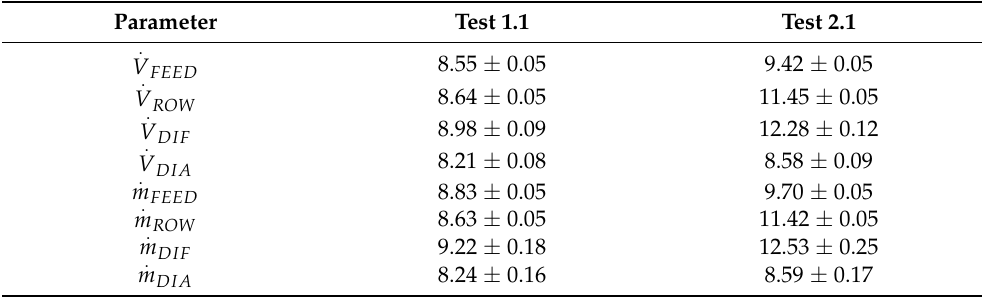
Table 2. Flows of inlet and outlet streams (volumetric flows in L · h − 1 and mass flows in kg · h − 1 ).